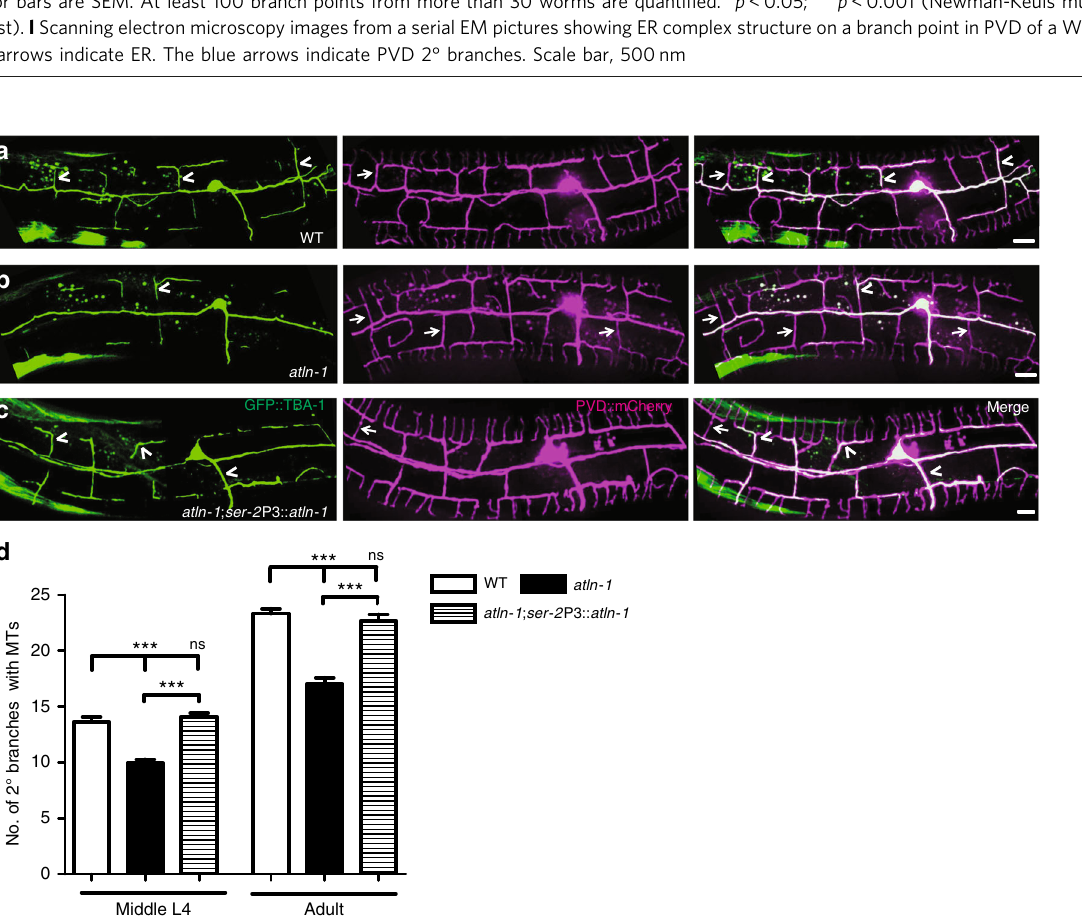
Fig. 4 ATLN-1 affects the presence of MT in dendritic branches. a – c Representative confocal images of MTs (GFP::TBA-1) and dendritic morphology of PVD neuron ( ser-2 P3::mCherry) in WT ( a ), atln-1 ( b ), and atln-1; ser-2 Prom3:: atln-1 adult worms ( c ). Arrows show PVD 2° branches without MTs and arrowheads indicate PVD 2° branches with MTs. Scale bars, 10 μ m. d Quanti fi cation of the number of 2° branches with MTs. Values are mean and error bars are SEM, n > 40. ns, not signi fi cant; *** p < 0.001 (Newman-Keuls multiple comparison